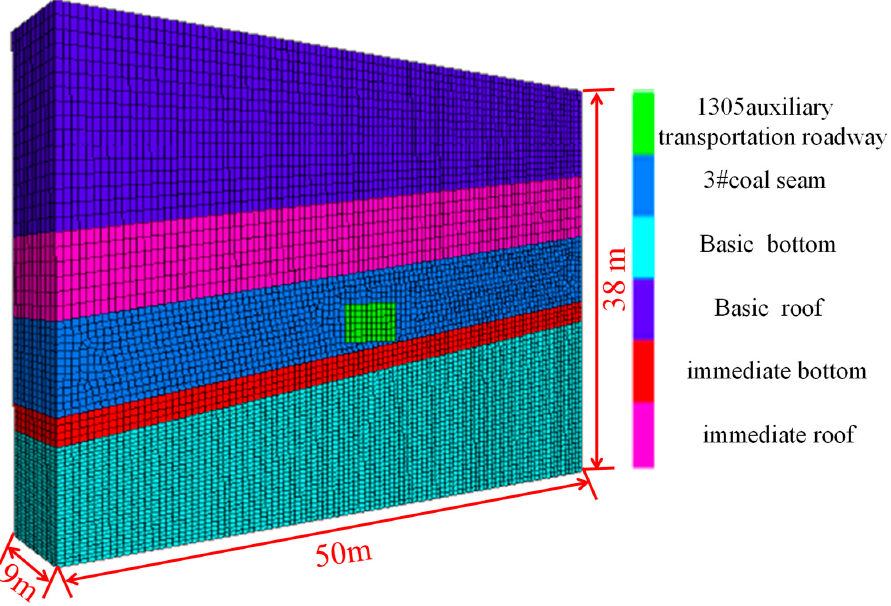
Table 1. Physical and mechanical parameters of rock.